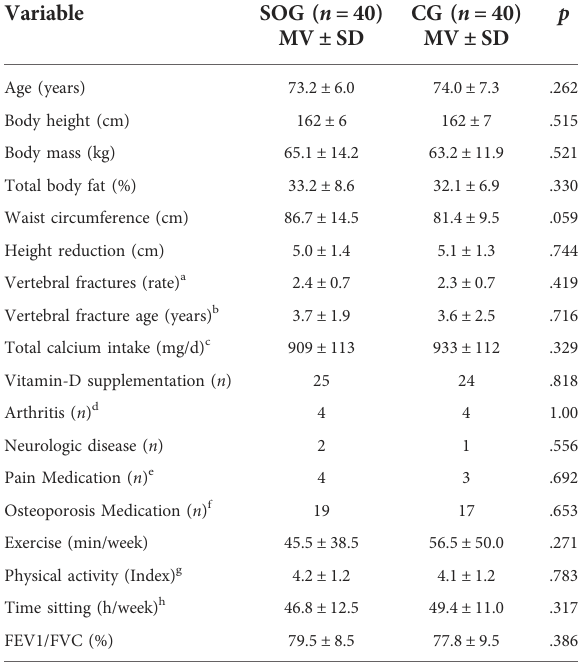
TABLE 1 Baseline characteristics of the spinal orthosis (SOG) and control group